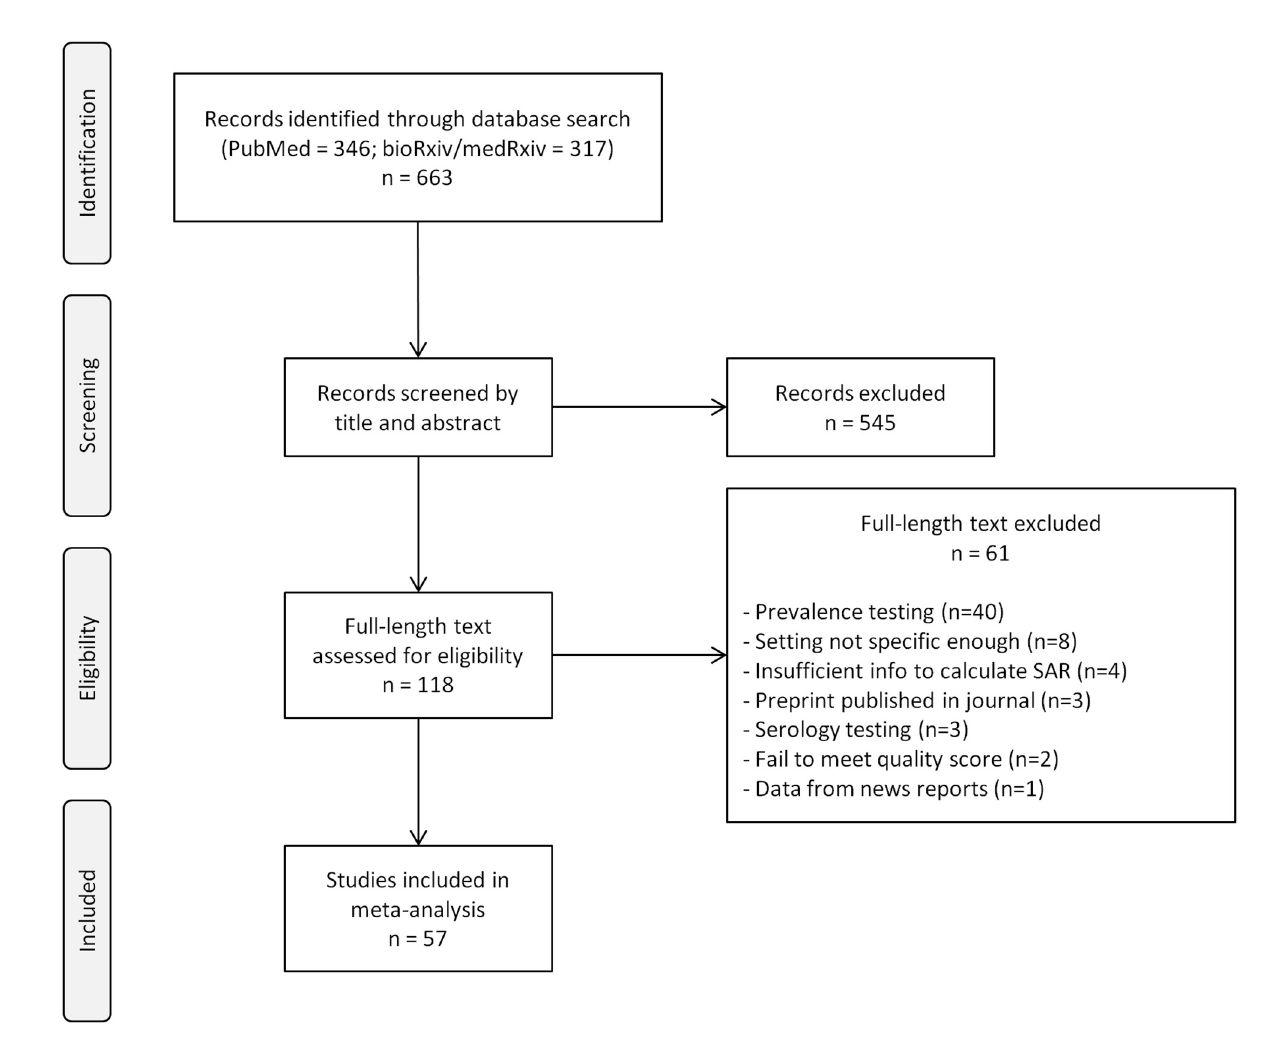
Fig 1. Flow chart of search strategy and study selection for the secondary attack rate